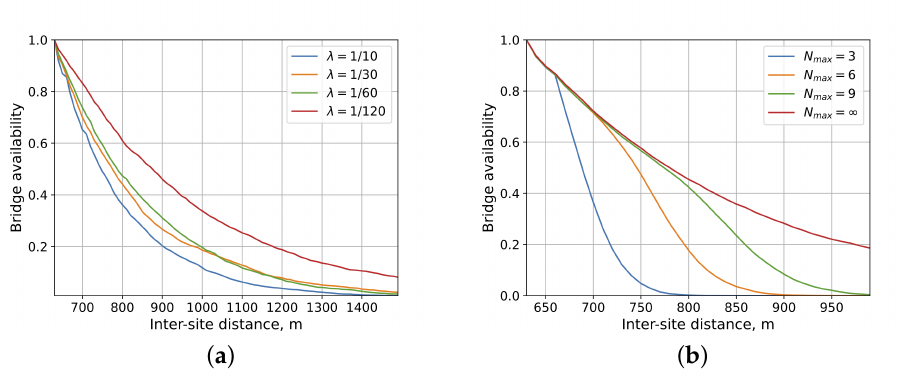
Figure 6. Bridge availability as a function of the inter-site distance. ( a ) different traffic conditions; ( b ) different number of hops.